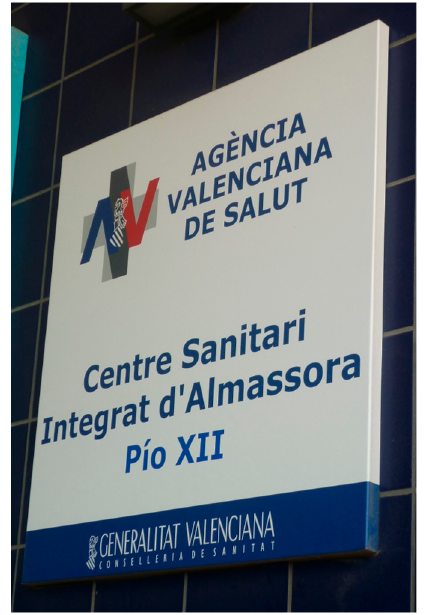
Figure 13. Almazora: Valencian-only sign on an outpatient clinic .